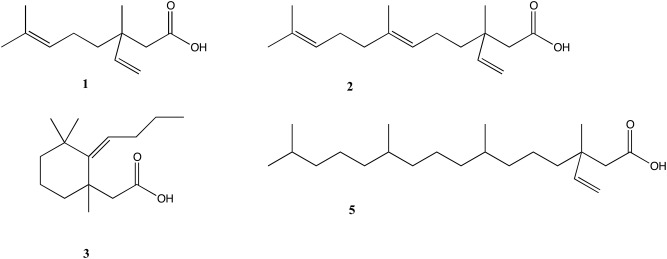
Prepared acids used in the synthesis of terpene phospholipids.